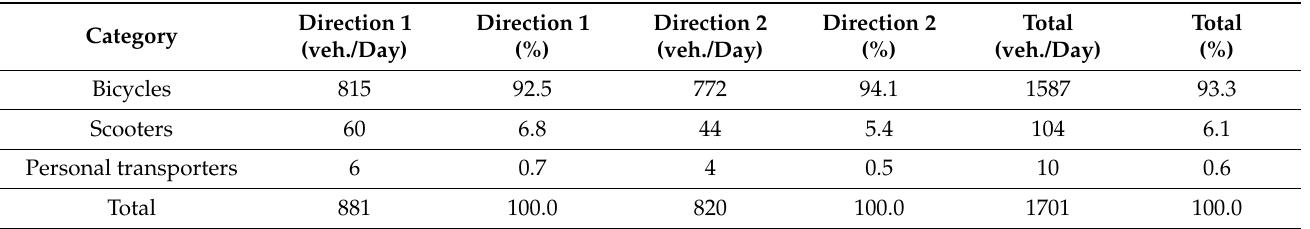
Table 1. Vehicle structure type at the bicycle lane along Stefana Banacha street, broken down by directions (own study).